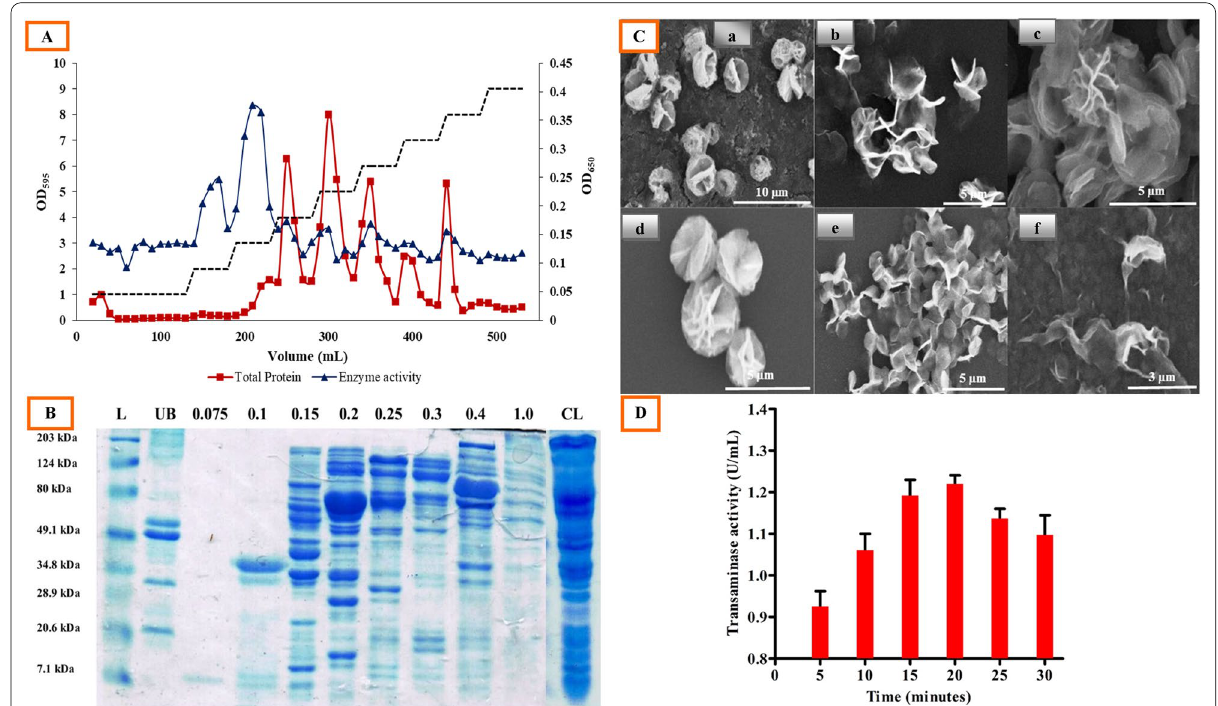
Fig. 1 A Chromatogram of transaminase purification in anion exchange column; B SDS-PAGE analysis of different elution fractions of anion exchange chromatography*; C SEM images of sonication time optimization study on nanoflower synthesis, a 5 min, b 10 min, c 15 min, d 20 min, e 25 min, and f 30 min; D TA activity of hNFs synthesized at different sonication time intervals. *Proteins were separated on a 12% polyacrylamide gel in the presence of 1% SDS. Here, lane 1 represents marker proteins (molecular mass 203, 124, 80, 49.1, 34.8, 28.9, 20.6, 7.1 kDa), lane 2 depicts unbound fraction, lane 3 depicts 0.075 M NaCl elution fraction, lane 4 depicts 0.1 M NaCl elution fraction, lane 5 depicts 0.15 M NaCl elution fraction, lane 6 depicts 0.2 M NaCl elution fraction, lane 7 depicts 0.25 M NaCl elution fraction, lane 8 depicts 0.3 M NaCl elution fraction, lane 9 depicts 0.4 M NaCl elution fraction, lane 10 depicts 1.0 M NaCl elution fraction, and lane 11 depicts cell lysate